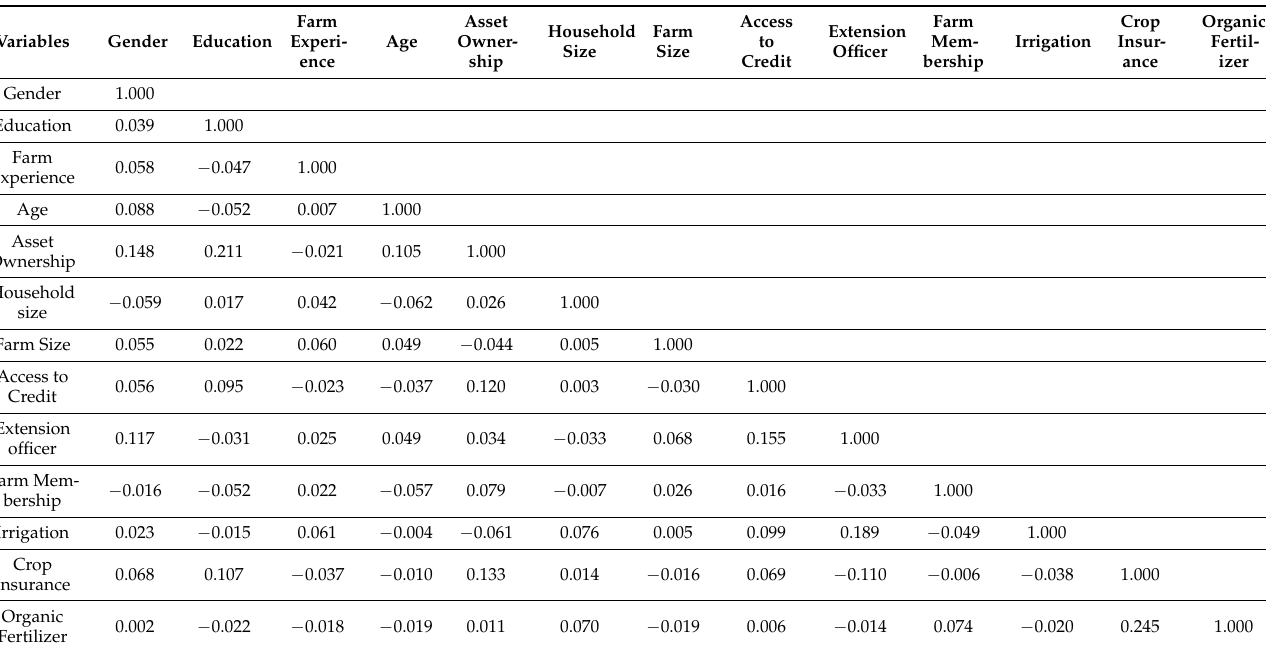
Table 3. Contingency coefficient test for co-linearity between independent